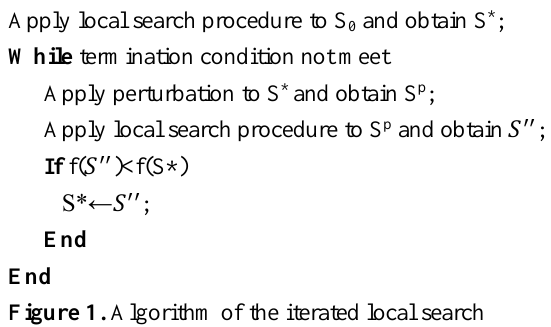
Figure 1. Algorithm of the iterated local search One of the important features of the proposed algorithm is to start the search process multiple times. This feature provides diversification. Initial solution of the algorithm is generated by randomly or by a greedy algorithm. Throughout our preliminary experiments, it was observed that the algorithm reached better solutions faster by using greedy algorithm as an initial solution finding mechanism. However, only the use of the greedy algorithm caused starting with very similar solutions. Thus, random solutions also taken as an initial solution for the investigation of the unexplored regions in the search space. For this, a random number is derived. If this random number is greater then q (a predetermined parameter) the algorithm uses the greedy algorithm. Otherwise random initial solution is generated. TS algorithm is used as a local search algorithm. The TS algorithm and perturbation mechanisms are applied respectively until the stopping criterion is achieved. Once the stopping criterion has been achieved, an initial solution is generated again and the steps are repeated until the number of multiple starting is